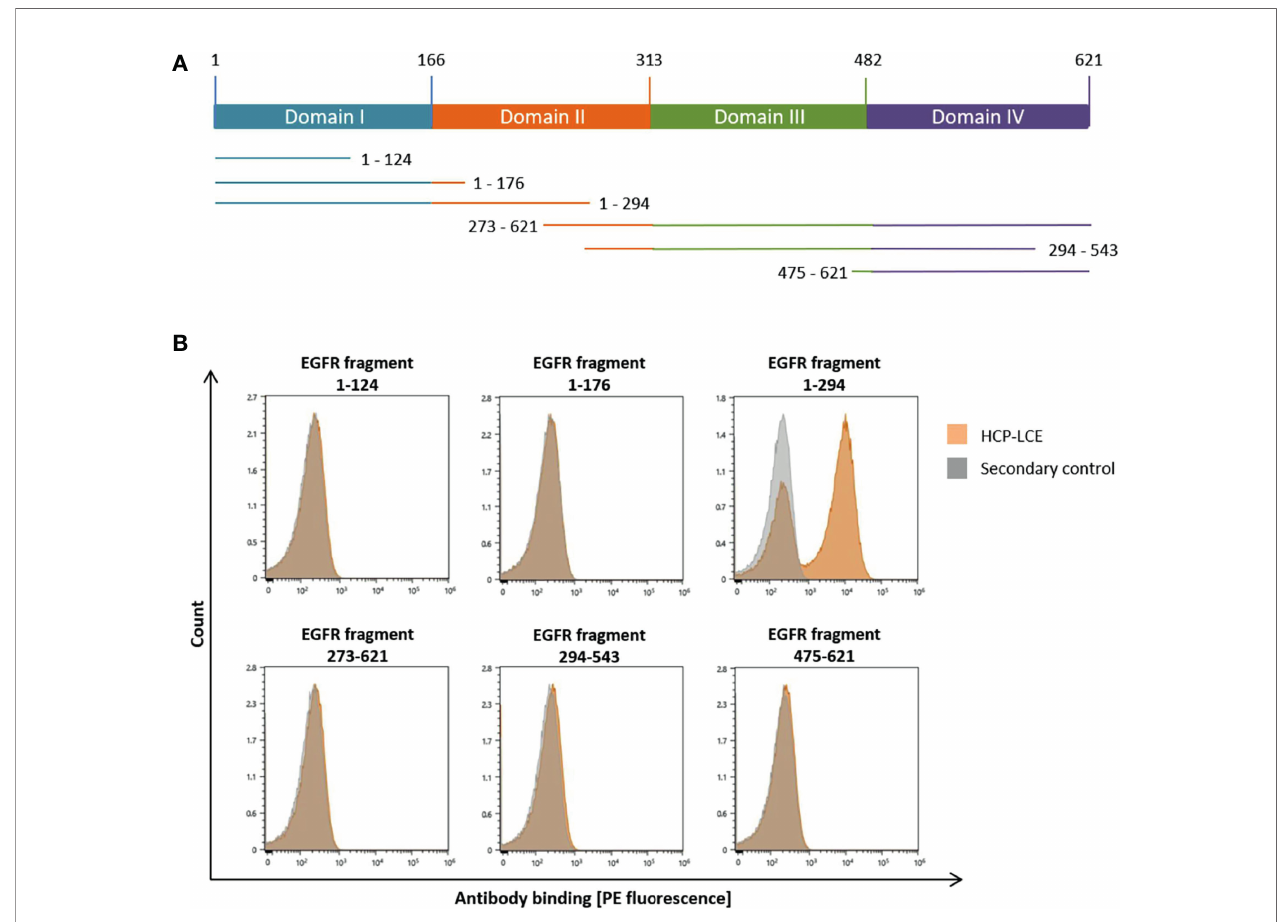
FIGURE 2 | YSD-based EGFR epitope mapping of HCP-LCE. (A) Schematic representation of EGFR extracellular domains I to IV and the six EGFR fragments investigated in this study. (B) Binding of HCP ‐ LCE (orange) to yeast cells expressing different truncated EGFR fragments was detected using the goat anti-human Fc PE antibody. Measurements without HCP-LCE (grey) served as a negative control. HCP-LCE binds to EGFR fragment